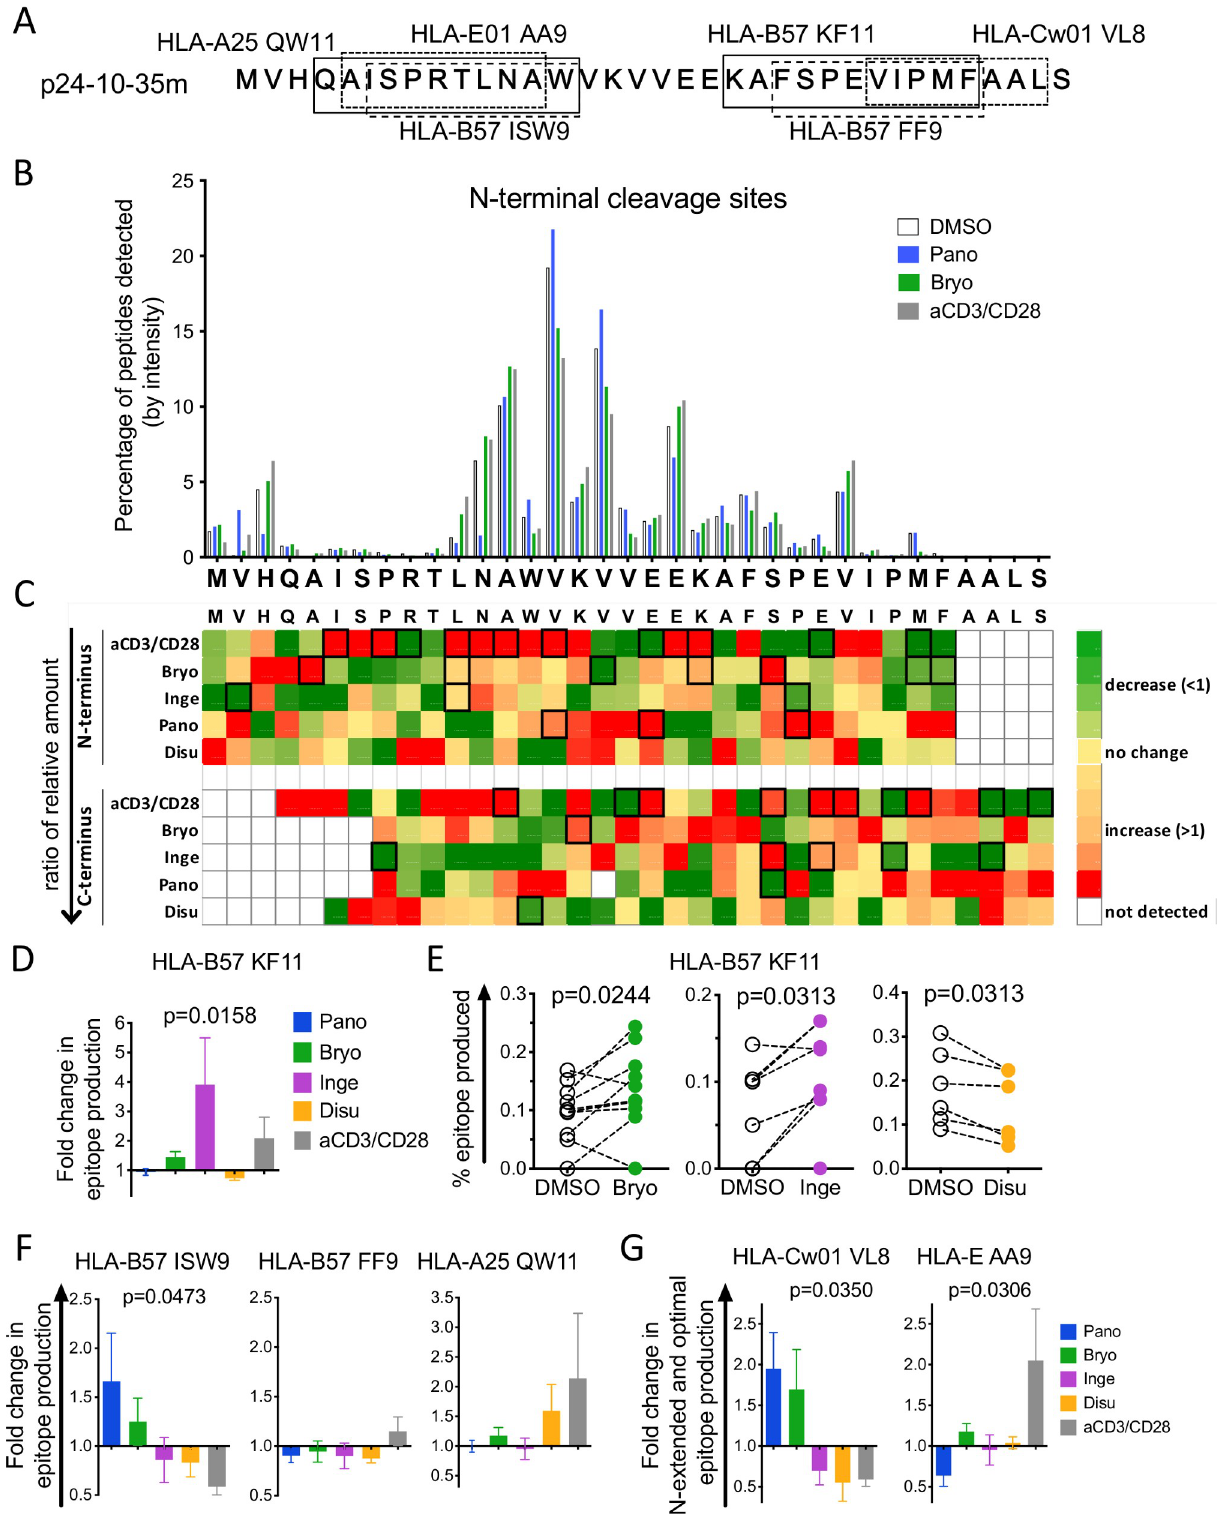
Fig 2. LRA treatments alter the degradation pattern of HIV-1 p24-10-35m and epitope production. A. Sequence of HXB2 HIV-1 Gag p24-10-35m substrate and MHC-I optimal epitopes. B. Cleavage patterns of p24-10-35m after a 120-minute degradation in extracts of primary CD4 T cells